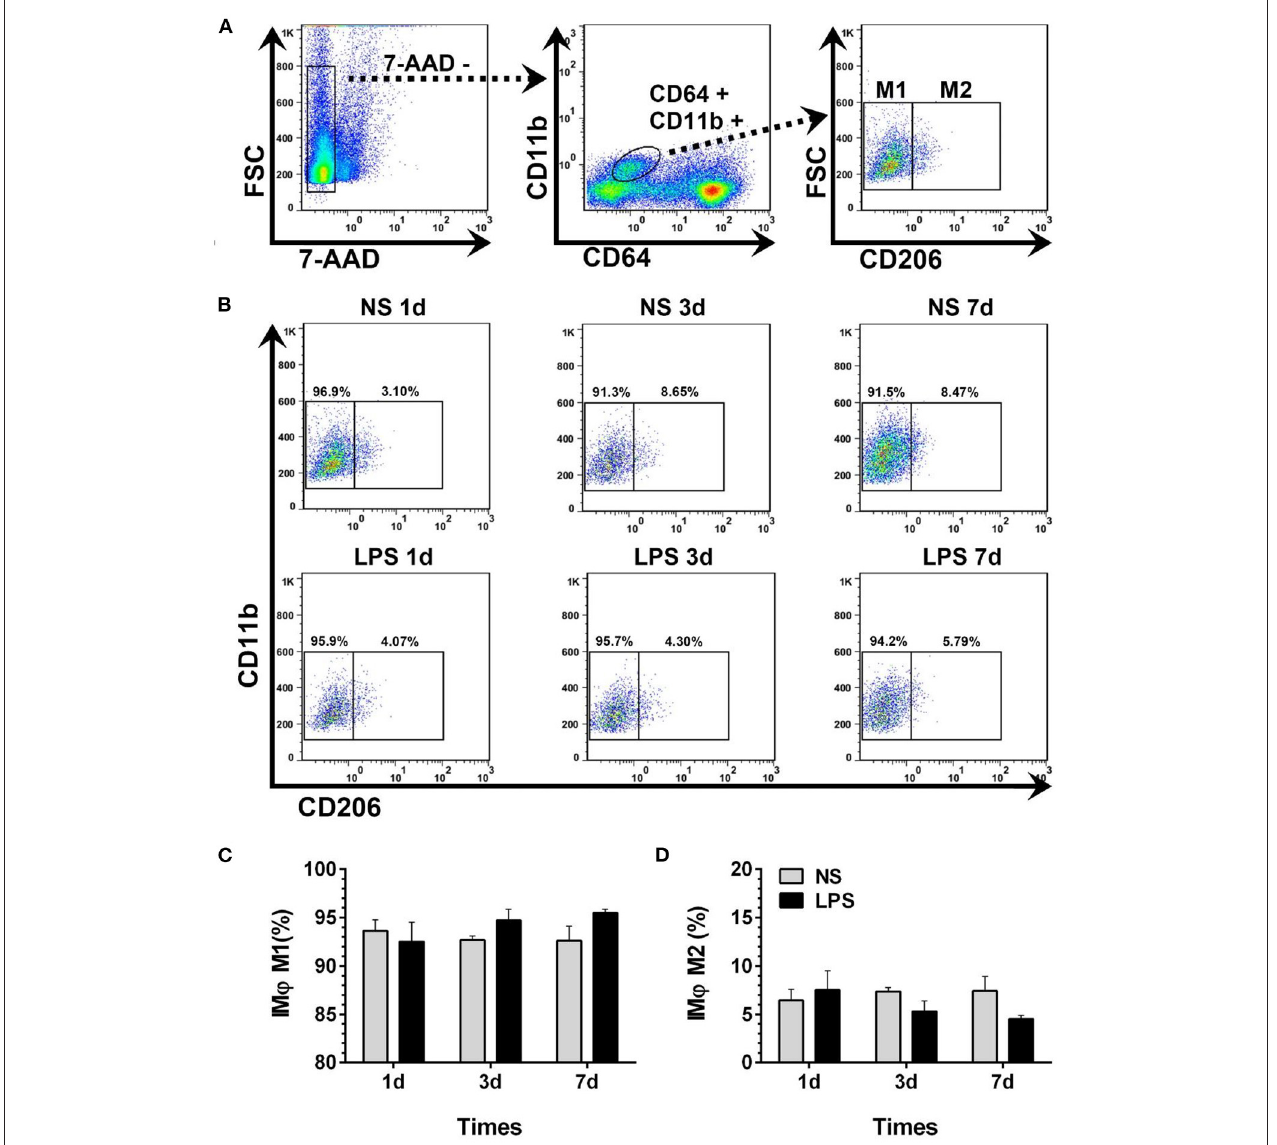
FIGURE 6 | Temporal dynamic changes of IM φ subpopulations after LPS stimulation. (A, B) M1- and M2-like IM φ were identified by flow cytometry. Numbers outside boxed areas indicated the percentage of cells. The gating strategies for pulmonary IM subpopulations is shown in (A) . The dynamic characteristics of lung M1- and M2-like IM φ in NS and LPS groups are shown in (B) . (C, D) Kinetics of increase in M1- and M2-like IM φ numbers in the lung tissue. FSC, forward-scattered light; SSC, side-scattered light. # p < 0.05, compared with the LPS group on day 1; ** p < 0.01. ( n = 5 in each